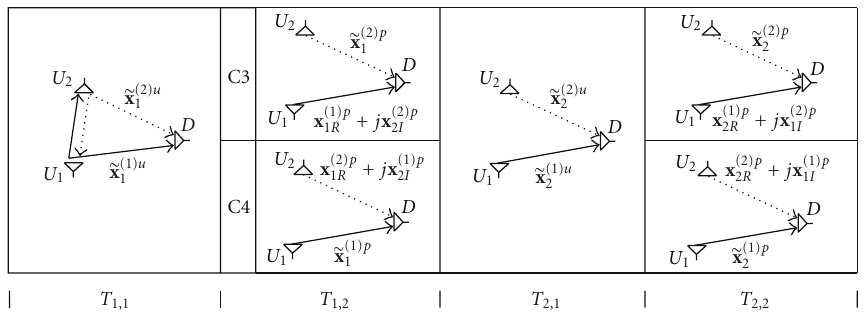
Figure 4: Scheme B: users know if the other cooperates or